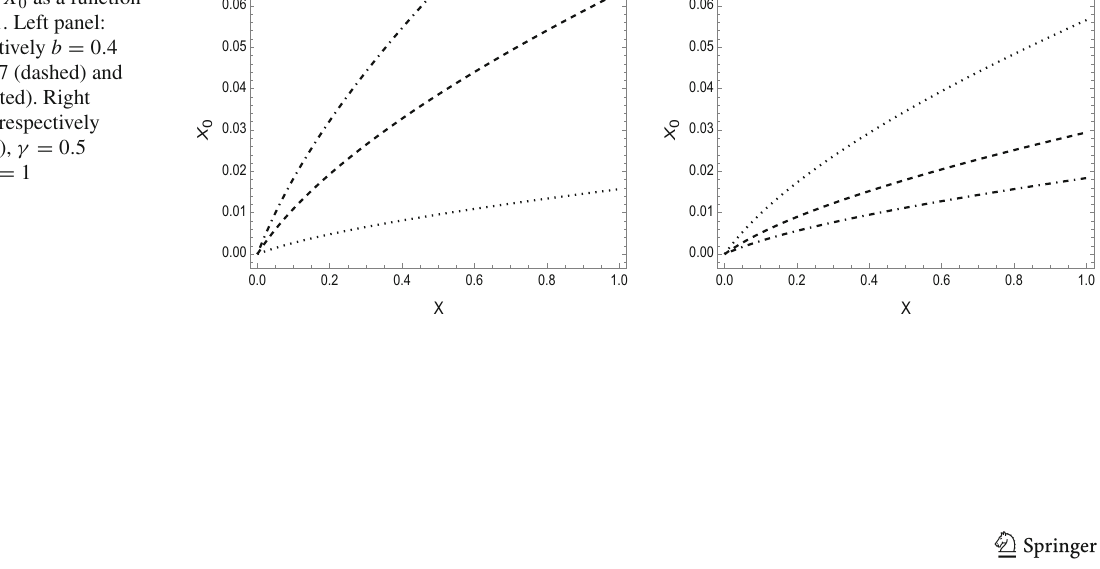
Fig. 4 Relative difference | ( ˜ M 0 − M 0 )/ M | as a function of X for q V = 0 . 1 (left panel), q V = 0 . 5 (center panel) and q V = 1 (right panel) Fig. 5 Plots of X 0 as a function of X for q V = 1. Left panel: γ = 0 . 5, respectively b = 0 . 4 (dotted), b = 0 . 7 (dashed) and b = 1 (dash-dotted). Right panel: b = 0 . 5, respectively γ = 0 . 1 (dotted), γ = 0 . 5 (dashed) and γ =